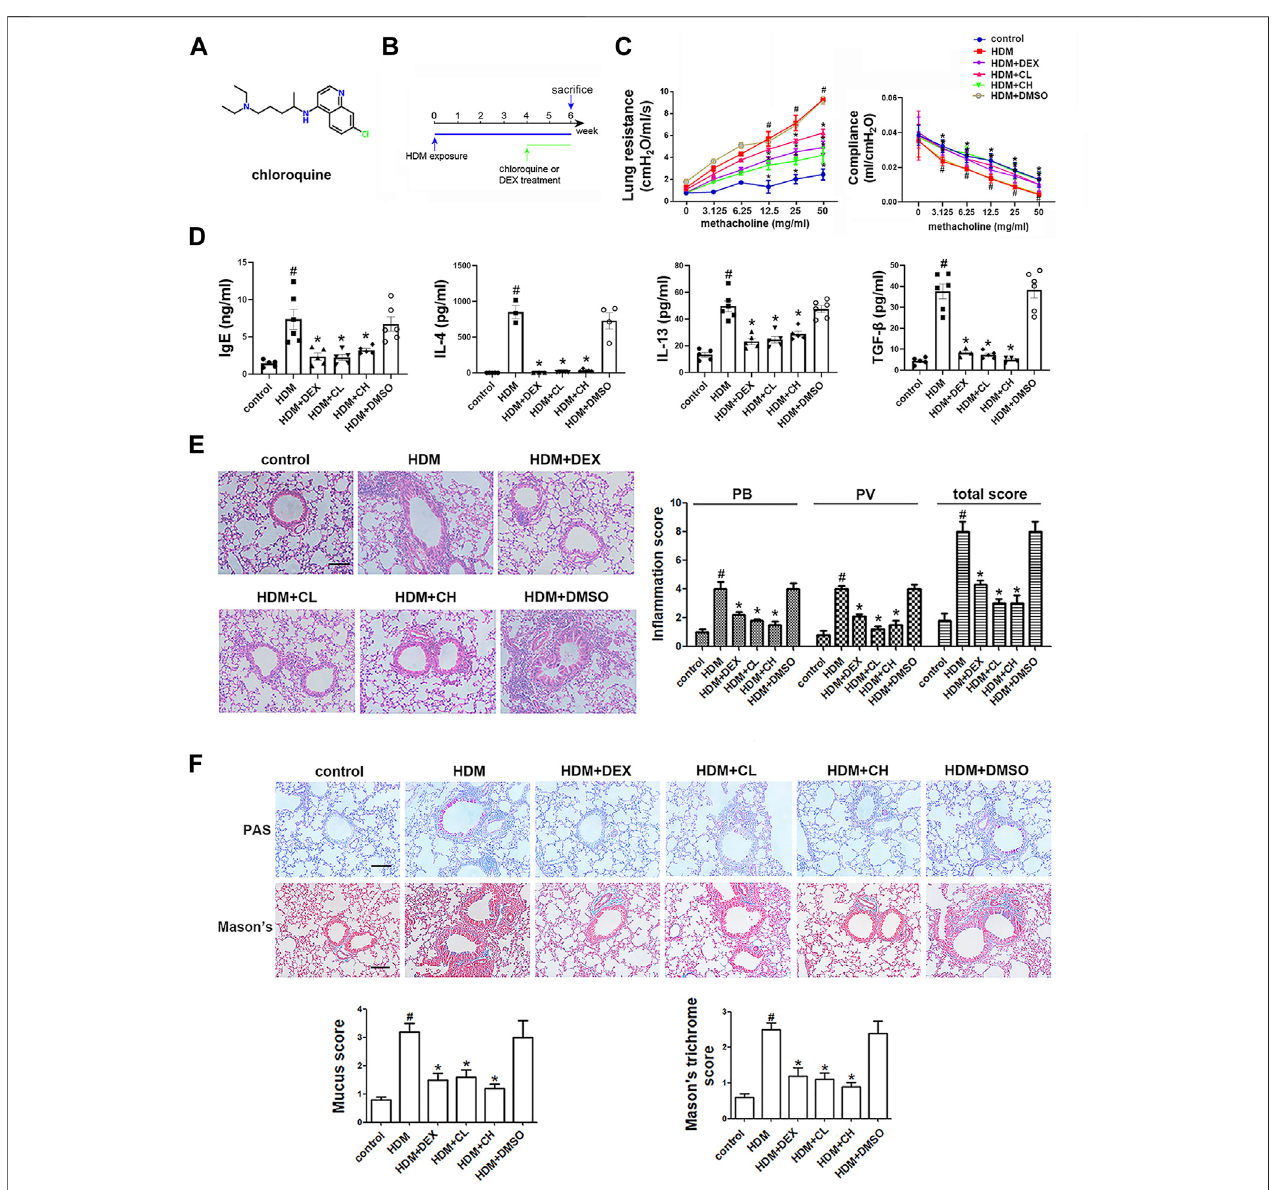
FIGURE 1 | Chemical structure of chloroquine and experimental protocol for the chronic asthma model. Treatment with chloroquine alleviated AHR, ameliorated lung dynamic compliance, decreased the levels of IgE, Th2 cytokines, and TGF- β 1 in BALF, and inhibited in fl ammatory cell in fi ltration, goblet cell hyperplasia, collagen deposition in lung (A) Chemical structure of chloroquine (B) Brief scheme of HDM sensitization and challenge (C) Increasing inhaled doses of methacholine (3.125 – 50 mg/ml),lungresistanceanddynamiccomplianceinmice (D) TheconcentrationsofHDM-speci fi cIgE,IL-4,IL-13,andTGF- β 1weremeasuredbyELISA (E) Lung sections were stained with H&E to analyze the in fi ltration of in fl ammatory cells (magni fi cation, ×400; scale bar, 50 µm). Layers of in fl ammatory cells were counted,andthetotalin fl ammationscorewassummedwiththeperibronchial(PB)andperivascular(PV)in fl ammationscores (F) LungsectionswerestainedwithPASto assess goblet cell hyperplasia and Masson ’ s trichrome to evaluate the subepithelial deposition of collagen and fi brosis (magni fi cation, ×400; scale bar, 50 µm). PAS- positiveandPAS-negativeepithelialcellswerecounted,andthepercentageofPAS-positivecellsperbronchiolewascalculated.Masson ’ strichromestaininganalysisof collagen deposition was calculated. Values are the mean ± SEM ( n = 6 per group). # p < 0.05 compared with the control group, and * p < 0.05 compared with the HDM group.